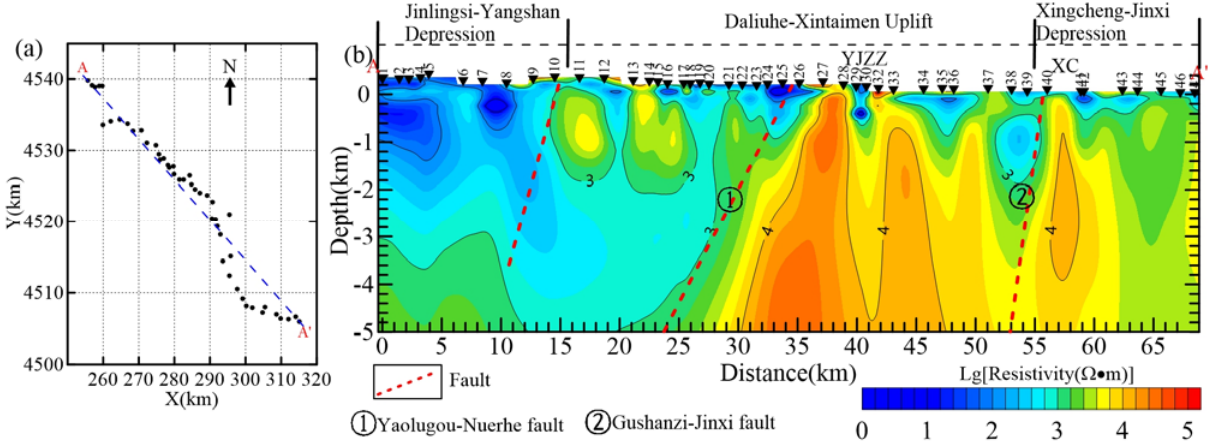
Figure 2. ( a ) MT survey profile AA ′ . The sites of MT stations are projected to AA ′ . ( b ) Inverted resistivity section of the MT survey. Geological units and faults are apparent in the resistivity model.